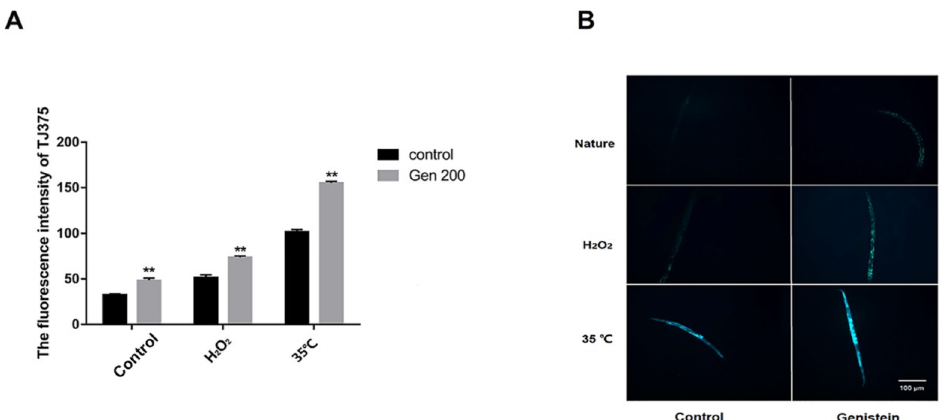
Figure 6. Under control, H 2 O 2 , and 35 ◦ C conditions, 200 µ M genistein influences the accumulation of HSP-16.2 protein in the stage L4 C. elegans . ( A ) The effect of genistein on the relative fluorescence intensity of HSP-16.2::GFP in C. elegans . ( B ) Micrograph of HSP-16.2::GFP fluorescence in C. elegans ( ** p < 0.01).